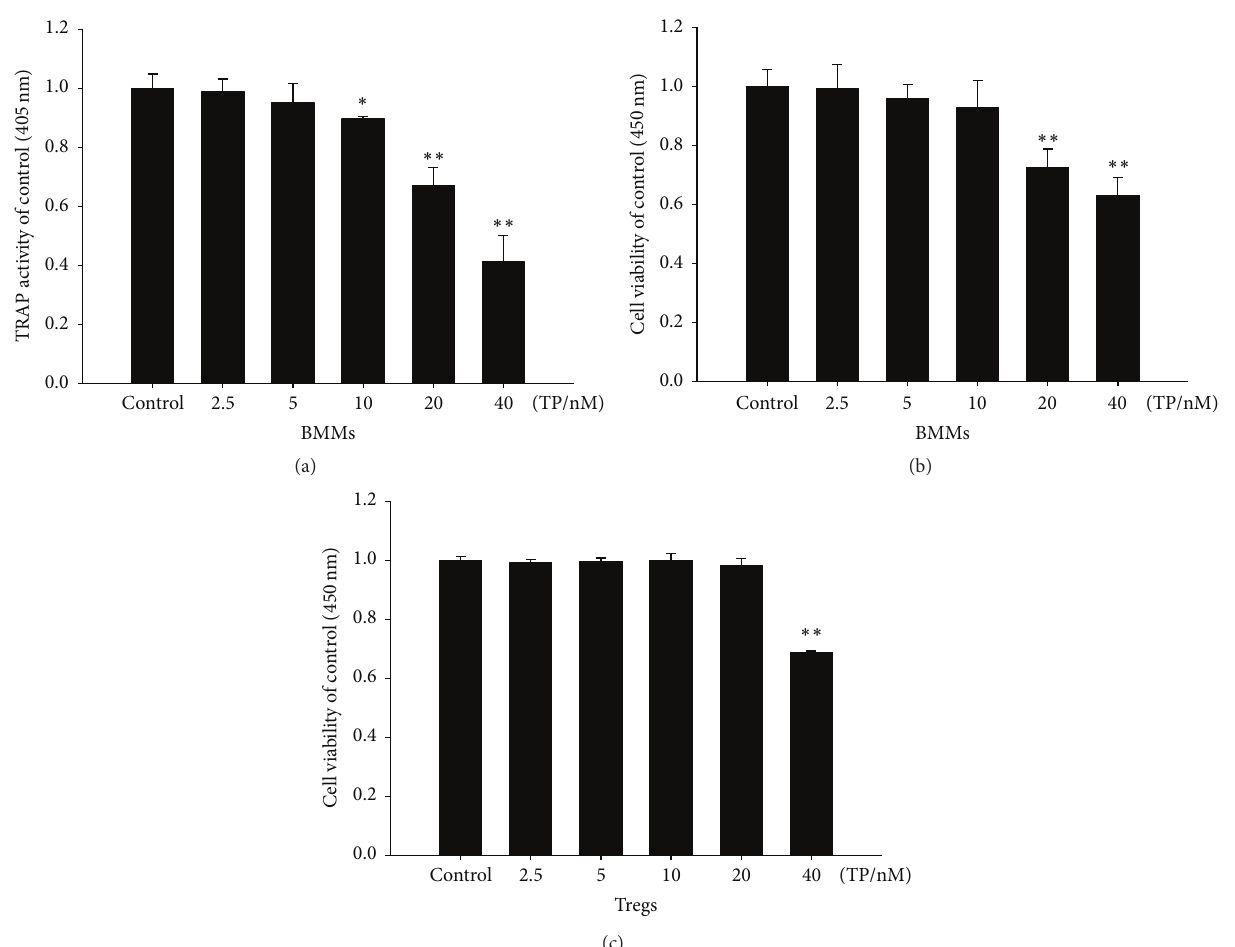
Figure 2: The effect of different concentrations of triptolide on BMMs or Tregs. (a) Mouse BMMs were treated with triptolide (2.5, 5, 10, 20, or 40 nM) in the absence of M-CSF and RANKL. TRAP activity was measured at a wavelength of 405 nm as described above. (b) Mouse BMMs were treated with triptolide (2.5, 5, 10, 20, or 40 nM) in the absence of M-CSF and RANKL. Cell viability was measured at a wavelength of 450 nm using the CCK-8 assay. (c) Activated Tregs were treated with triptolide (2.5, 5, 10, 20, or 40 nM), and cell viability was measured at a wavelength of 450nm using the CCK-8 assay. ∗ 𝑃 < 0.05 and ∗∗ 𝑃 < 0.01 compared with the control group (TP 0 nM